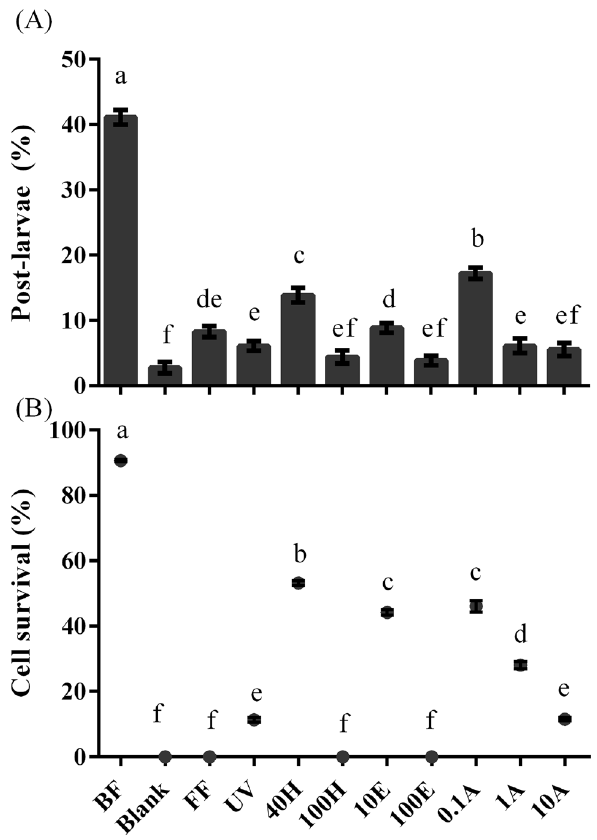
Figure 4. Post-larval rate ( A ) and cell survival ( B ) of deep-sea Virgibacillus sp. 1 BFs treated. Small letter suggests significant variance ( p < 0.05). Post-larval rate: Means ± SE (n = 9); cell survival: Means ± SE (n =